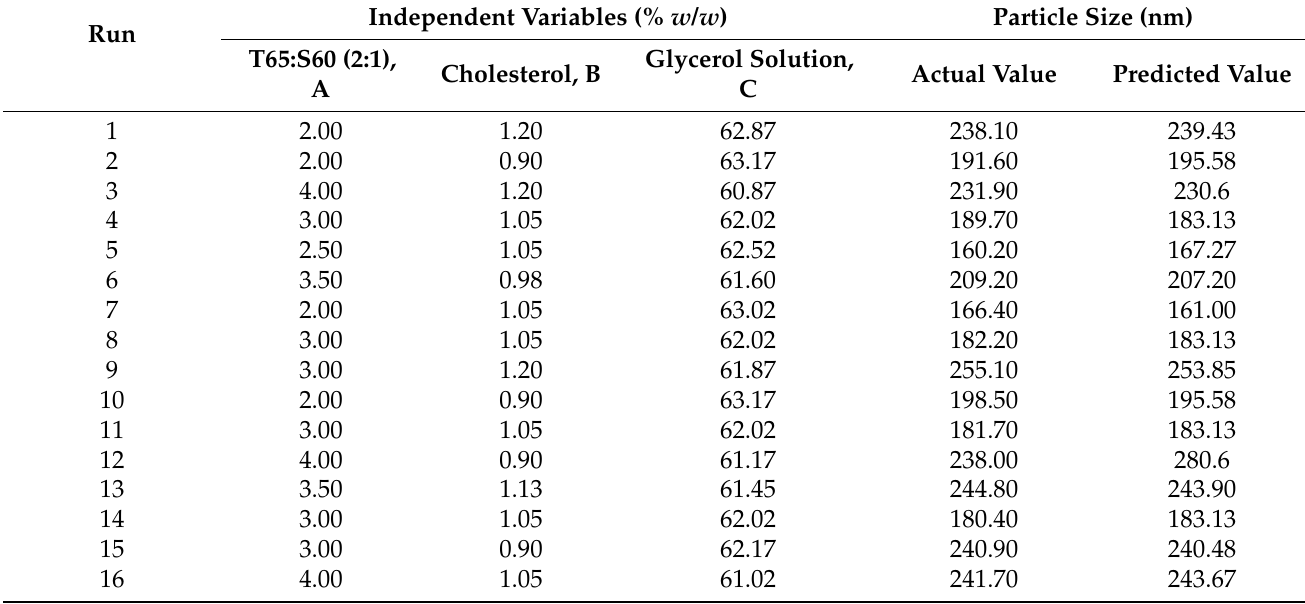
Table 3. Predicted and actual values of particle sizes of the composition of the niosome obtained from Design-Expert.